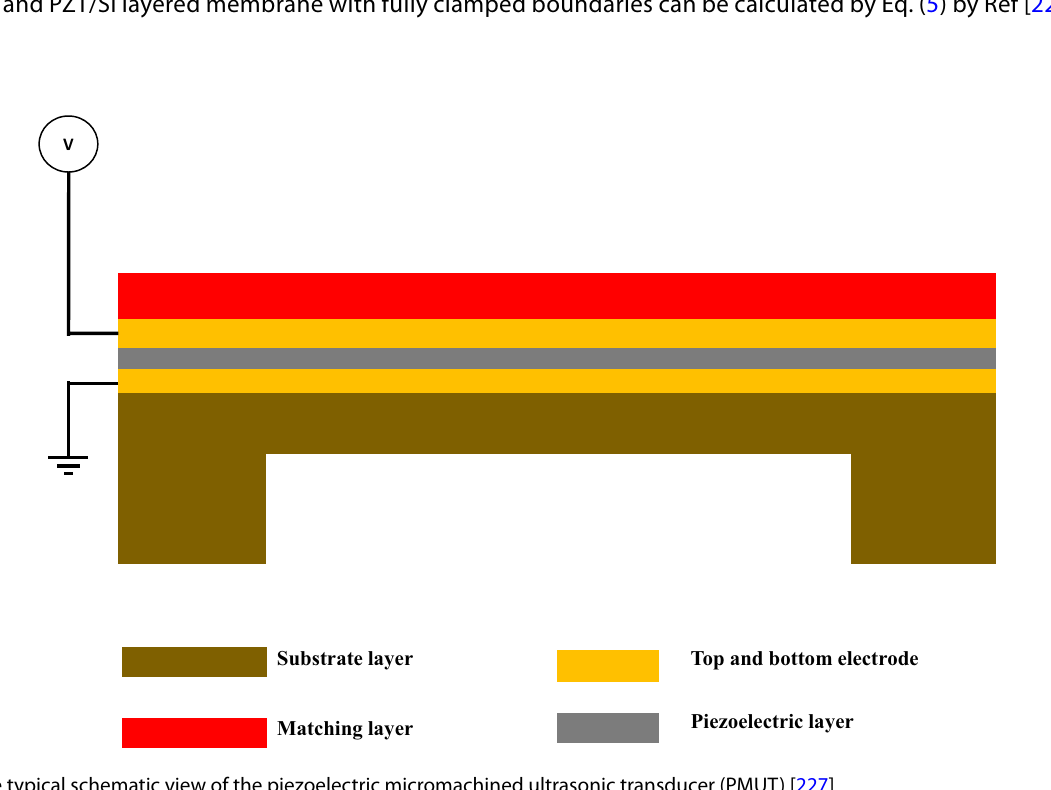
Fig. 11 The typical schematic view of the piezoelectric micromachined ultrasonic transducer (PMUT)